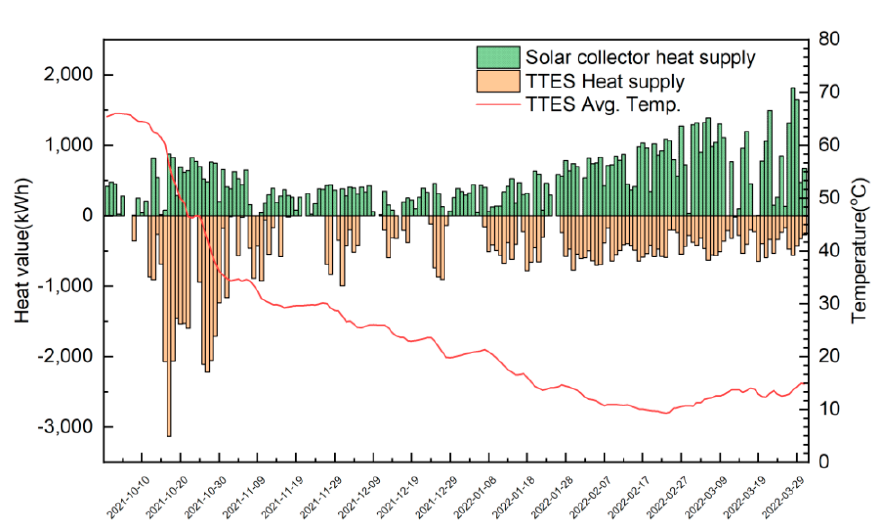
Figure 5. Daily heat balance of the TTES.